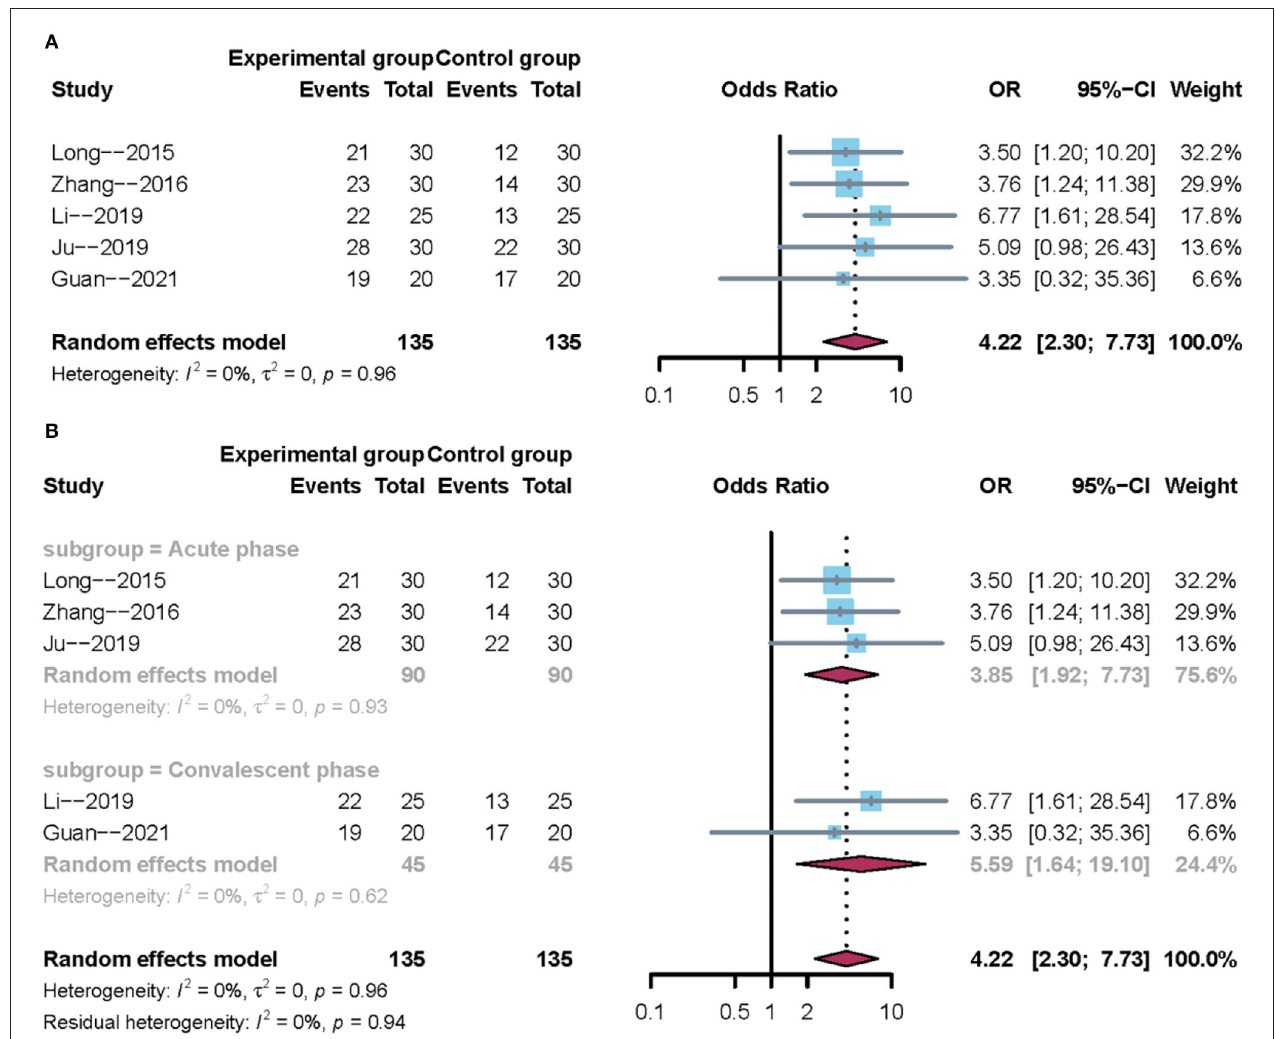
FIGURE 3 | Forest plot of the clinical effectiveness rate. (A) Overall analysis of five included trials. (B) Subgroup analysis on the stroke phase (Acute phase vs. Convalescent